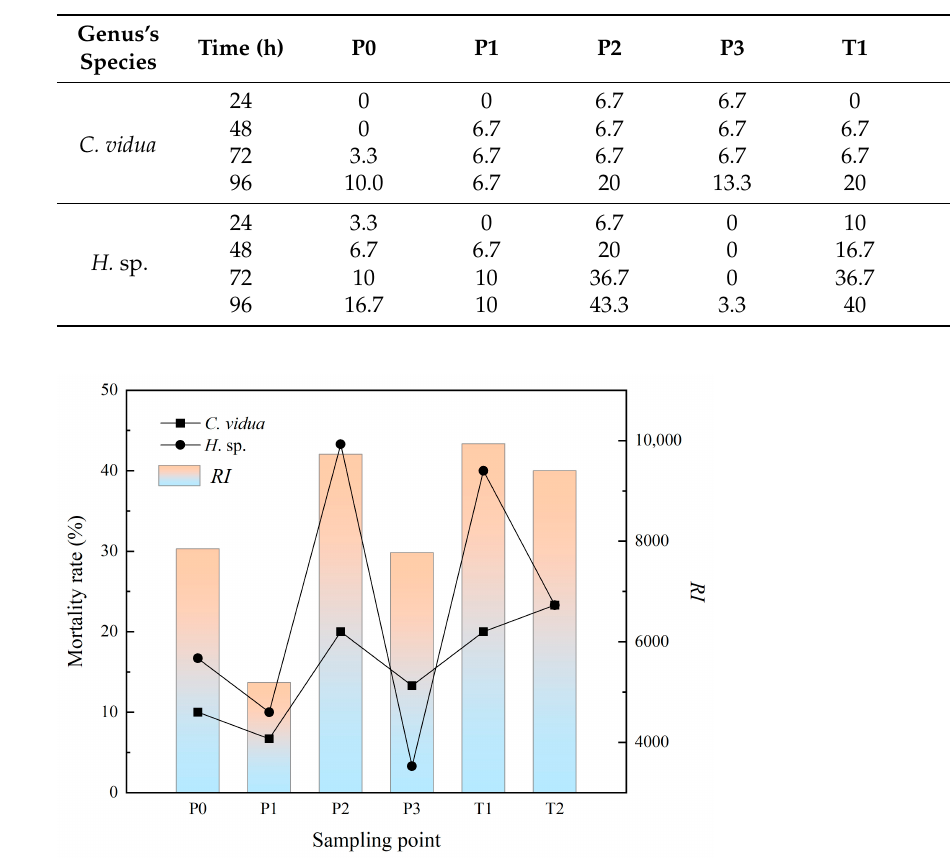
Table 9. Mortality results from ecotoxicity tests (%).